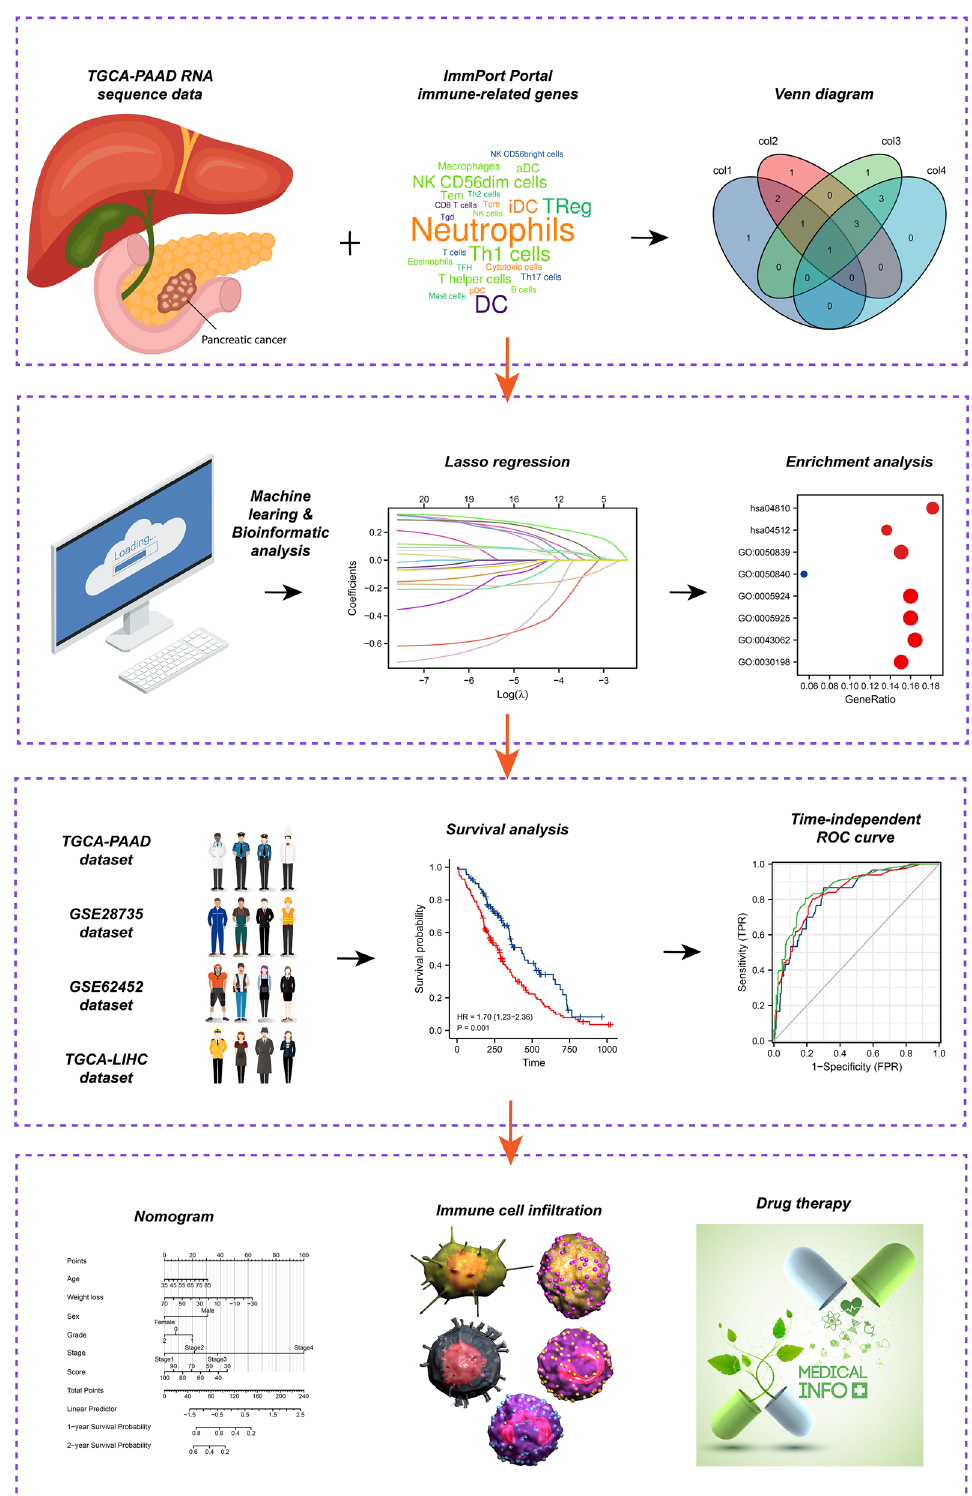
Figure 1. Study design flow chart. TCGA the cancer genome atlas, PAAD pancreatic adenocarcinoma, LIHC liver hepatocellular carcinoma, ROC receiver operating characteristic curve. This cover has been designed using images from